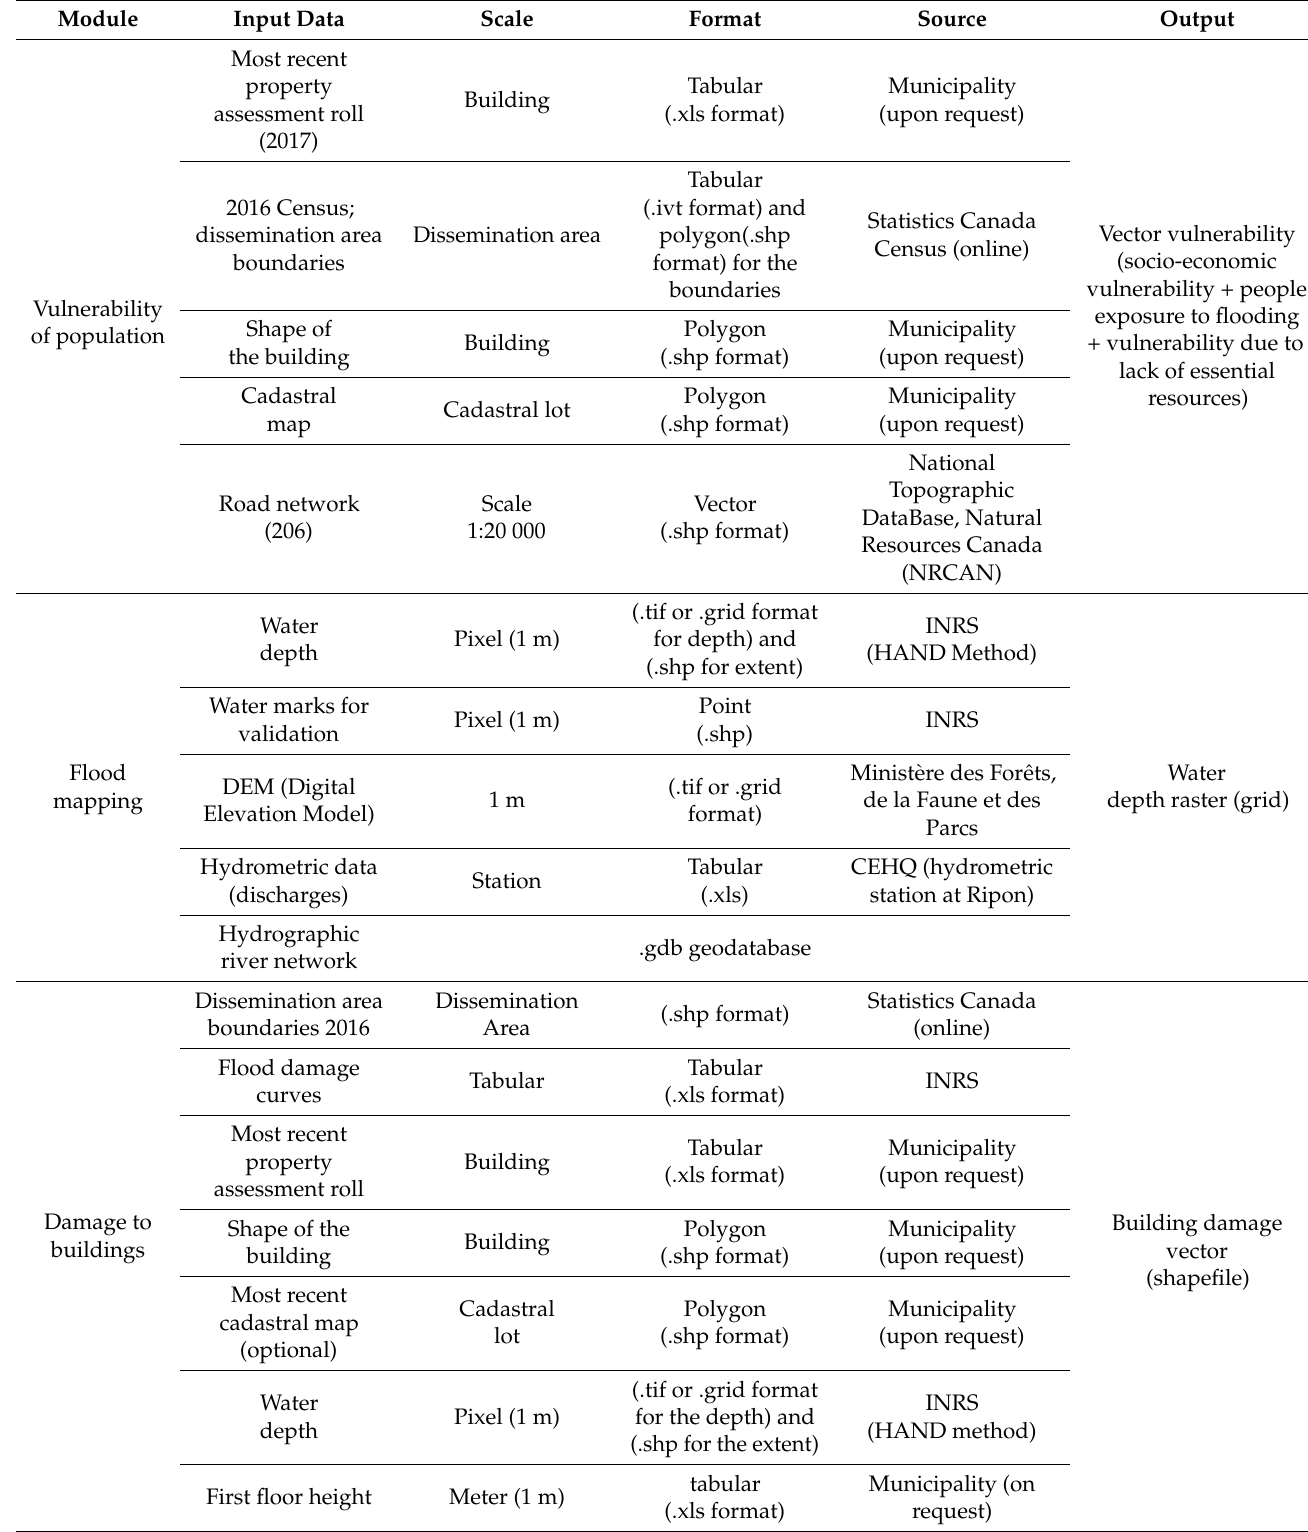
Table 1. Data used for the construction of the story